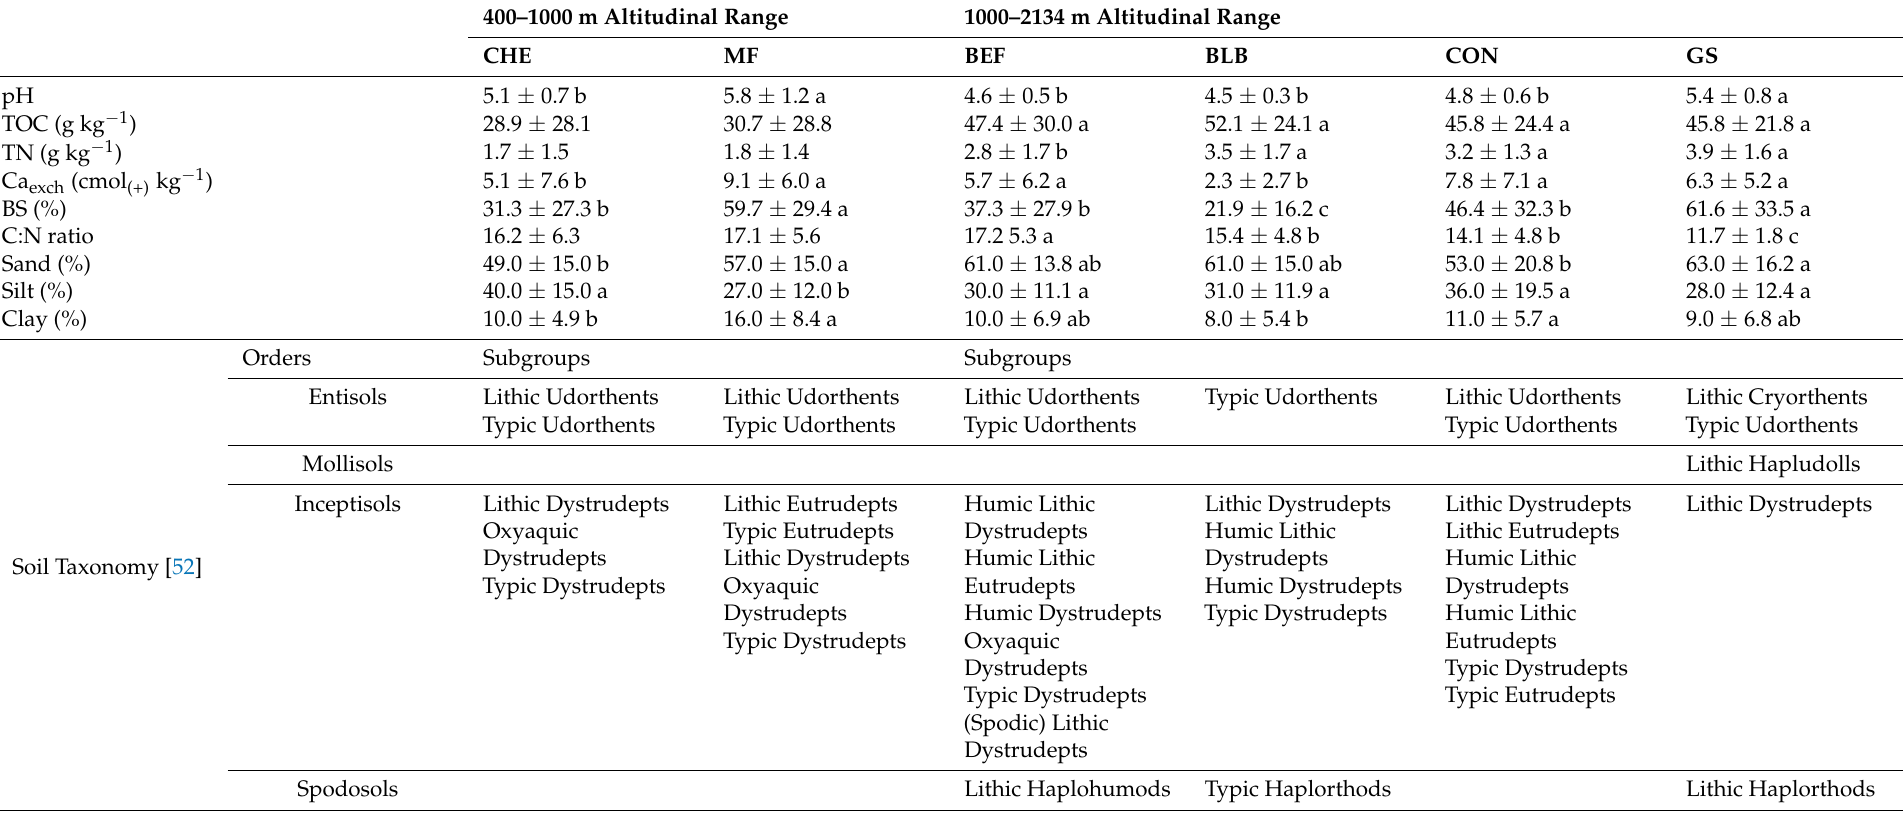
Table 2. Mean ± standard deviation of pH; base saturation (BS) and C:N ratio values; and concentrations of total organic carbon (TOC), total nitrogen (TN), exchangeable Ca (Ca exch ), sand, silt, and clay at a 0–30 cm soil depth, as well as identified soil types according to Soil Survey Staff [52] of chestnut groves (CHE), mixed forests (MF), beech forests (BEF), blueberry (BLB), coniferous forests (CON), and grasslands (GS) located within 400–1000 m and 1000–2134 m altitudinal ranges of the northeastern Apennine chain (Italy). Within each altitudinal range, different letters indicate significant differences (Kruskal–Wallis test, p < 0.05) among the